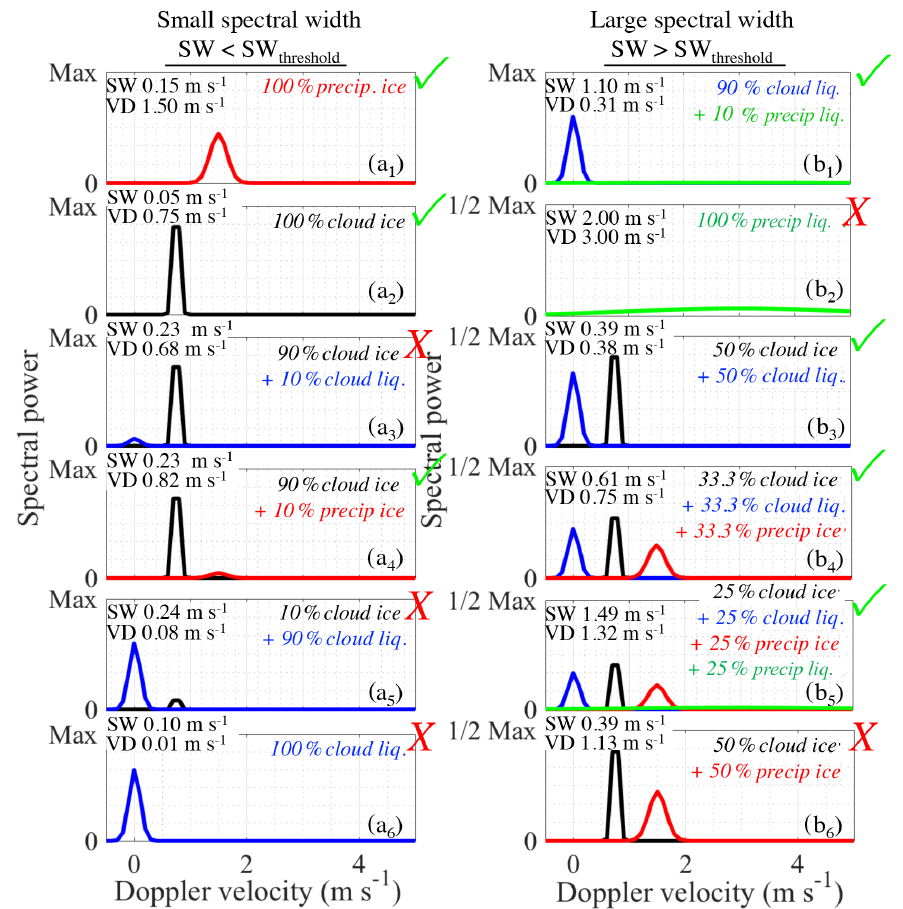
Figure 5. Cartoon examples of radar Doppler spectra from different hydrometeor combinations: precipitating ice (red), cloud ice (black), precipitating water (green), and cloud water (blue). The contribution of each hydrometeor species to the total copolar reflectivity is indicated in the top right of each subpanel. Each radar Doppler spectrum has been normalized to have the same total copolar radar reflectivity, which highlights the fact that different hydrometeor combinations generate unique mean Doppler velocity (VD) and Doppler spectral width (SW) signatures. As discussed in Sect. 6, low spectral width signatures are assumed to be associated with ice conditions (column a ), while high spectral width signatures are assumed to be associated with liquid–mixed-phase conditions (column b ). Hydrometeor combinations that √ respect these assumptions are marked with marks. Exceptions to these rules ( X marks) are responsible for (GO) 2 -SIM phase misclassifi- cations above the level of lidar extinction. This list is not